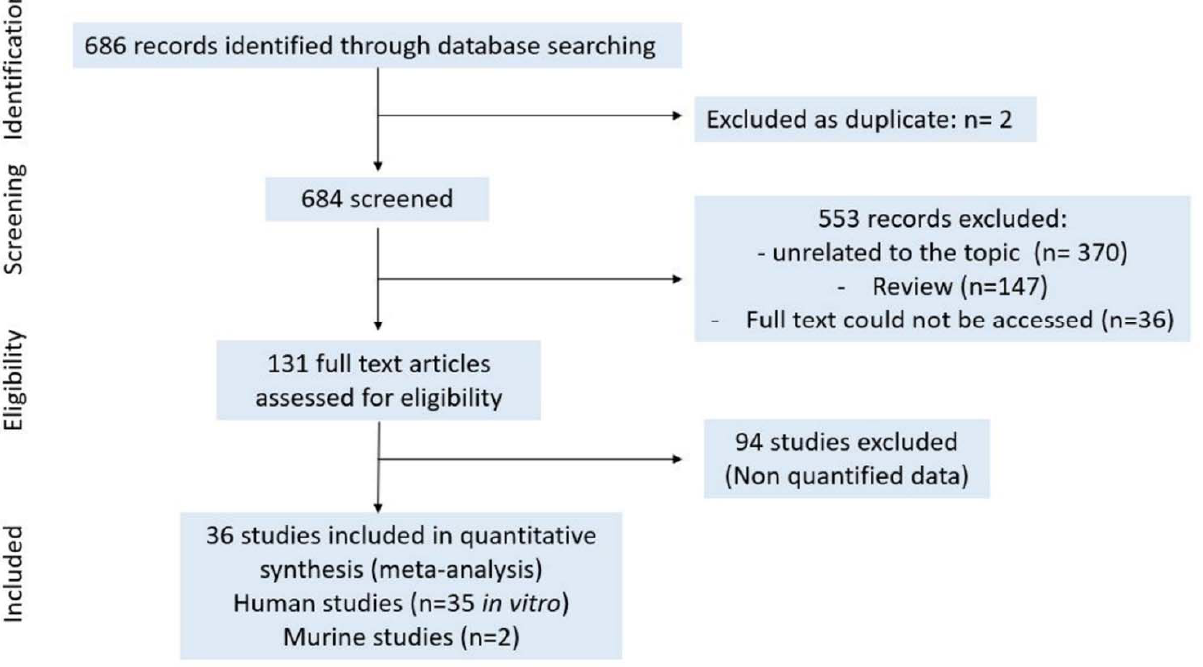
Figure 2. Study selection for miRs.